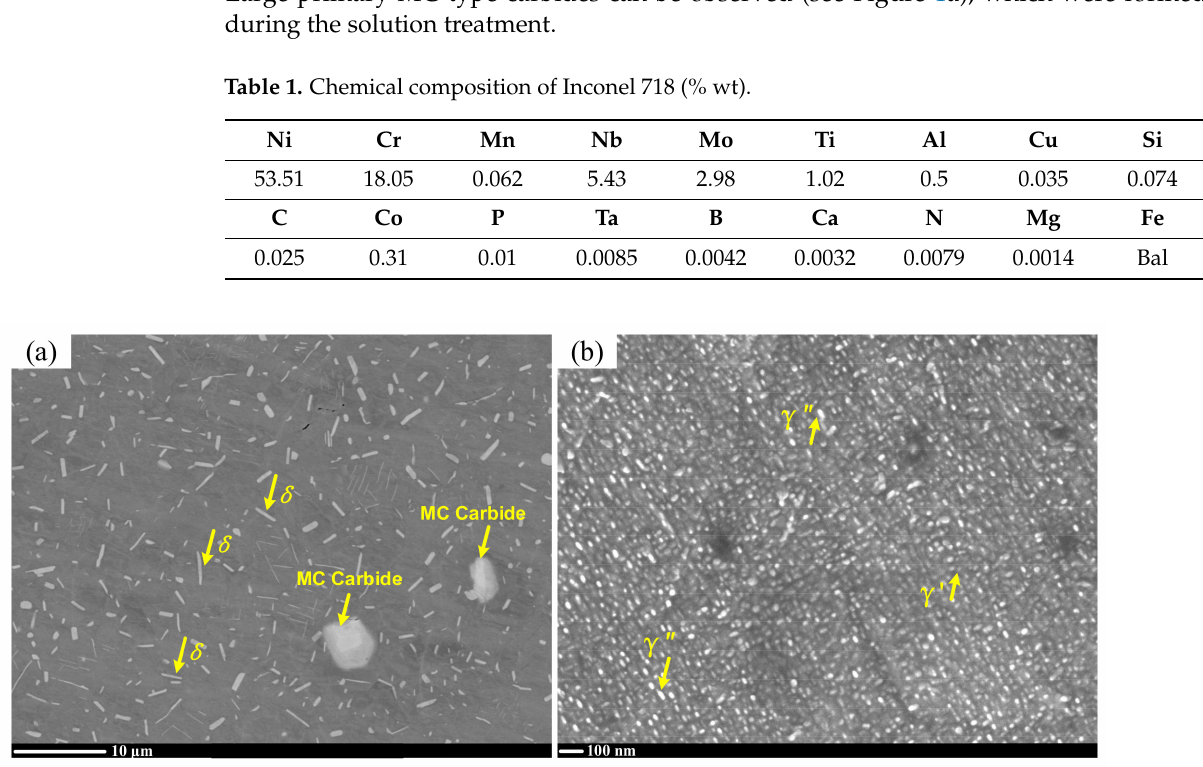
Figure 1. Microstructure of Inconel 718 at ( a ) medium and ( b ) high magnification scanning electron microscopy